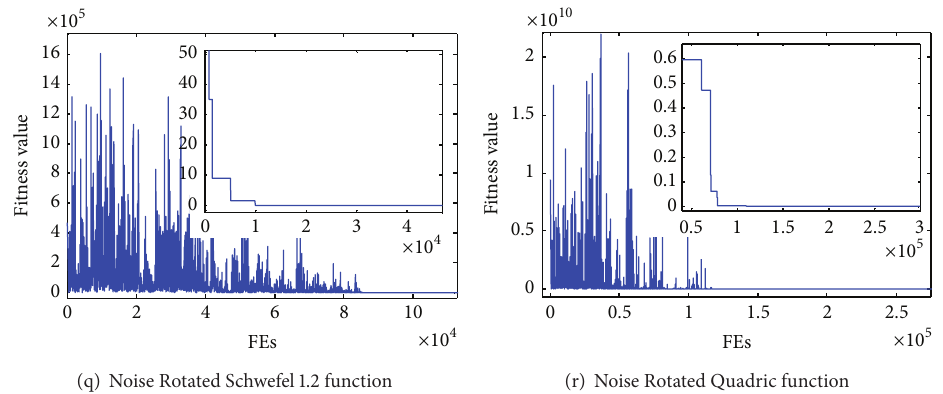
Figure 1: Evolutionary process of a particle and the global best solution with regard to each test